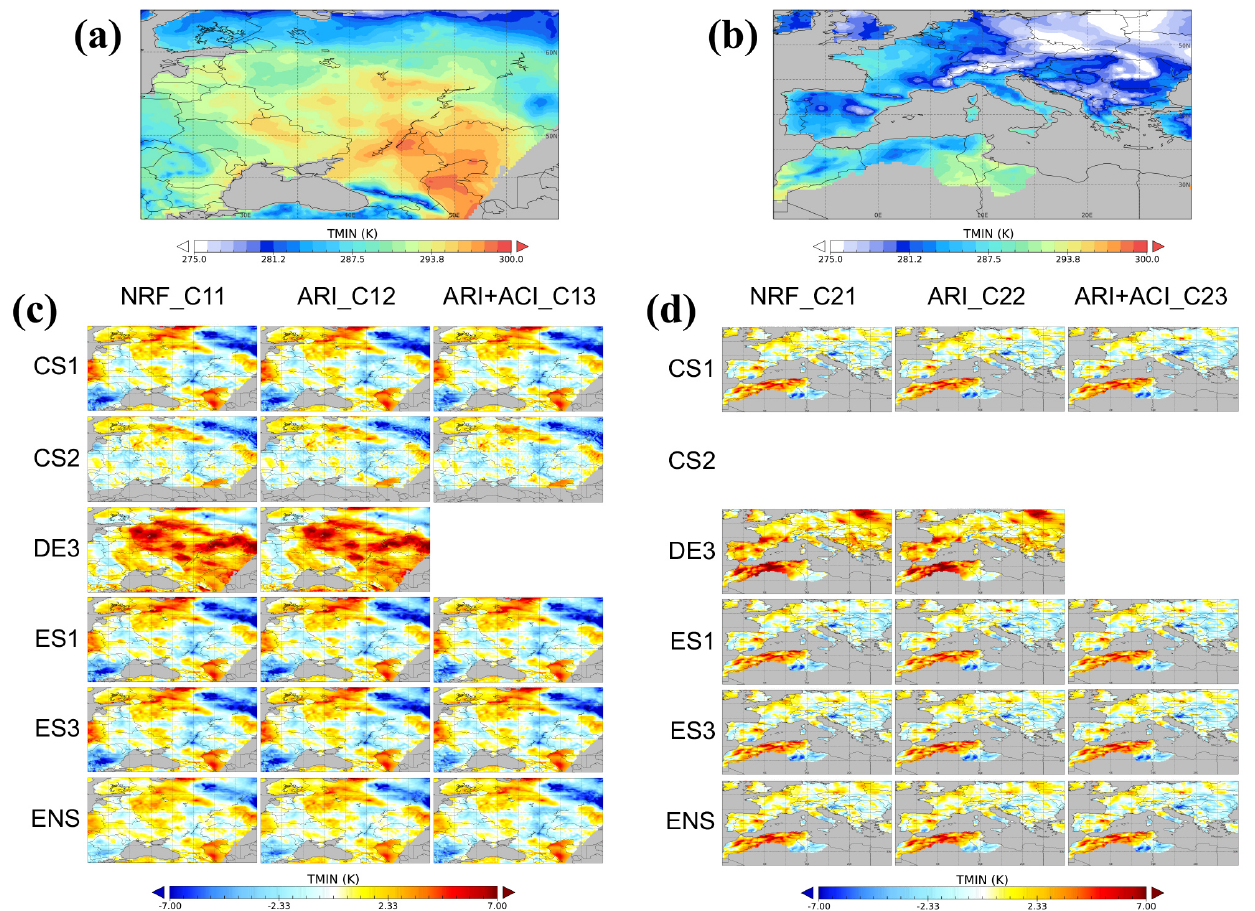
Figure 4. Minimum temperature (TMIN) for the fire (a) and dust (b) episodes, as derived from the E-OBS database (in K). The panels below represent the bias for the fire (c) and dust (d) episodes of each simulation with respect to the E-OBS database.